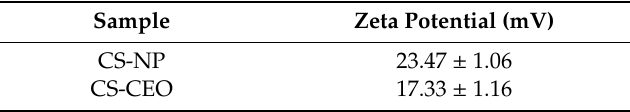
Table 2. Zeta potential of CS-NP and CS-CEO